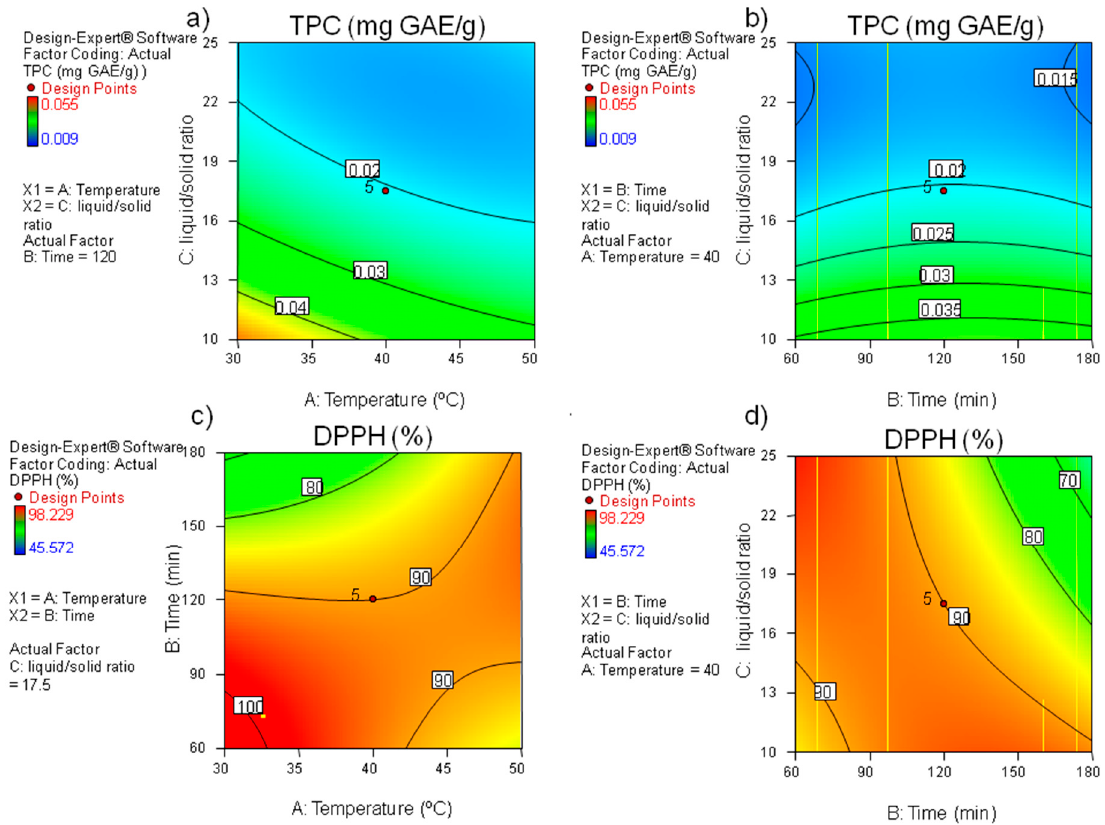
Figure 1. Contour plots for the effect of extraction variables on ( a , b ) TPC (mg gallic acid/g BSG) and ( c,d ) DPPH values (% inhibition).